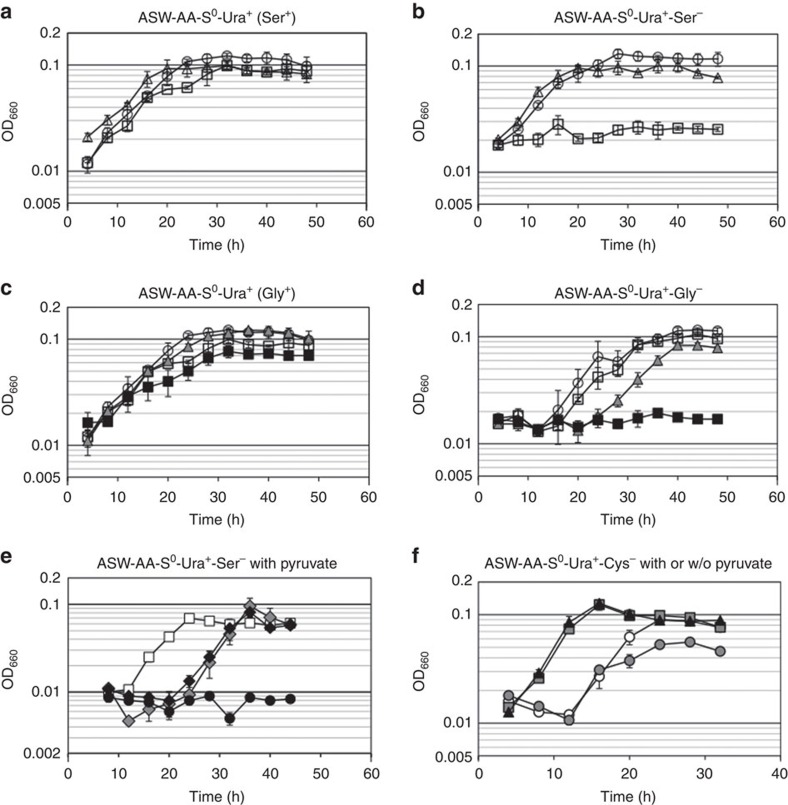
Ser, Gly or Cys auxotrophy of Thermococcus kodakarensis gene disruptants.Ser or Gly auxotrophy was investigated by cultivating cells in synthetic amino acid medium with (a) or without Ser (b) or with (c) or without Gly (d). Symbols: T. kodakarensis KU216 (open circles), ΔserAΔldhA1ΔldhA2-1 (open triangles), ΔglyA (open squares), Δtdh (grey triangles), ΔglyAΔtdh (black squares). Contribution of the route from 3-phosphoglycerate to Ser biosynthesis was examined in synthetic amino acid medium supplemented with pyruvate and depleted of Ser (e). Contribution of the route from 3-phosphoglycerate to Cys biosynthesis was examined in synthetic amino acid medium depleted of Cys with or without pyruvate (f). (e) Symbols: ΔglyA (open squares), ΔglyAΔserA (black circles), ΔglyAΔldhA1 (grey diamonds), ΔglyAΔldhA2 (black diamonds). (f) Symbols: KU216 host strain (open circles), ΔserK (grey circles), KU216 host strain with pyruvate (grey squares), ΔserK with pyruvate (black triangles). Error bars indicate the standard deviations of three independent culture experiments.